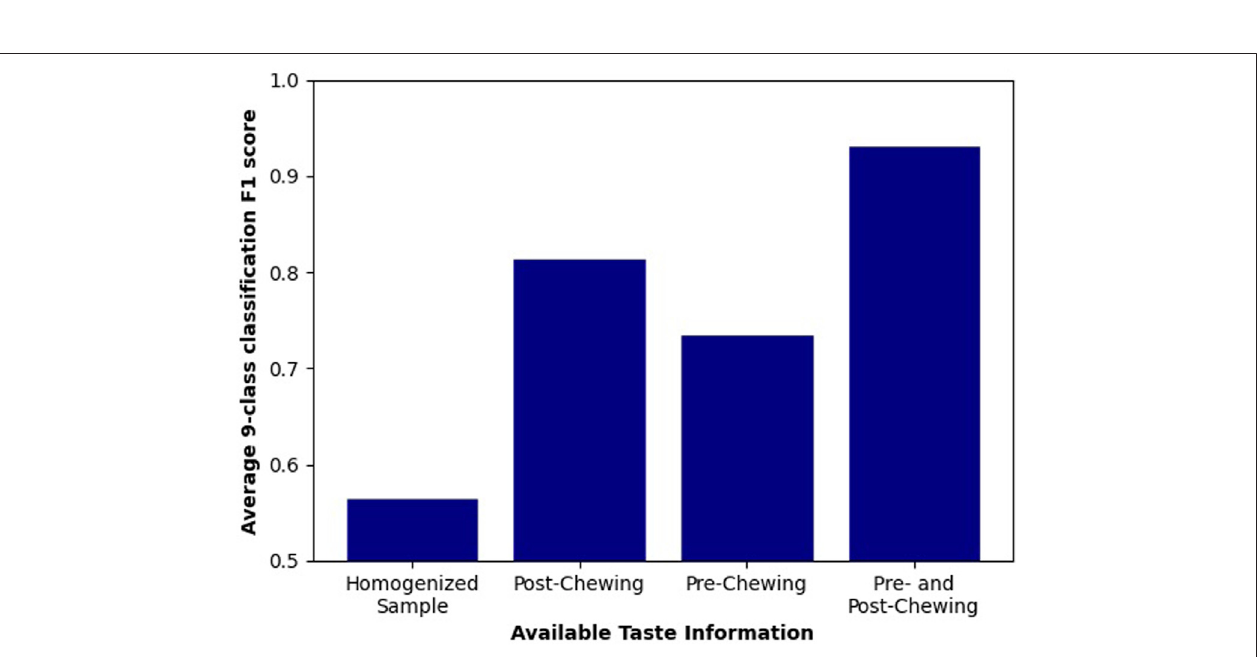
Frontiers in Robotics and AI |